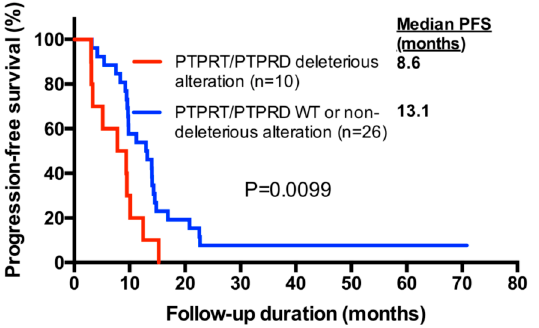
Figure 4. Progression-free survival (PFS) according to PTPRT/PTPRD alteration status. Progression-free survival upon bevacizumab treatment of all study cohort patients is shown in a Kaplan–Meier plot. Statistical analysis was performed with the Log-rank test.